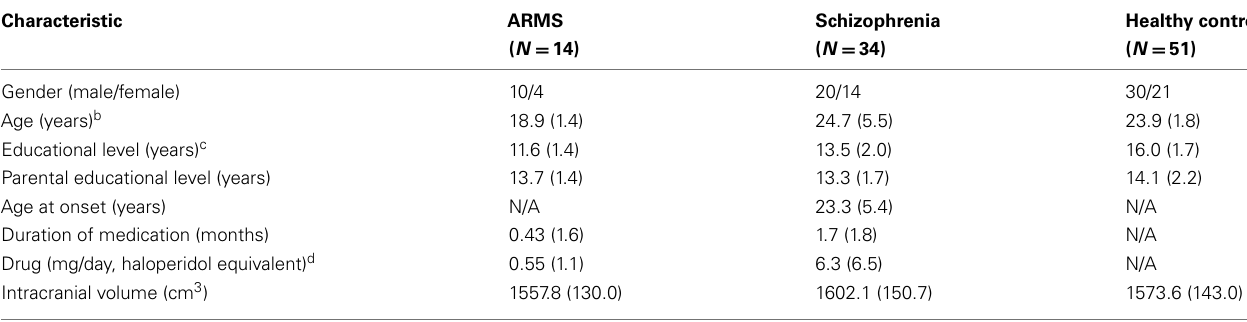
Table 1 | Clinical and demographic characteristics a